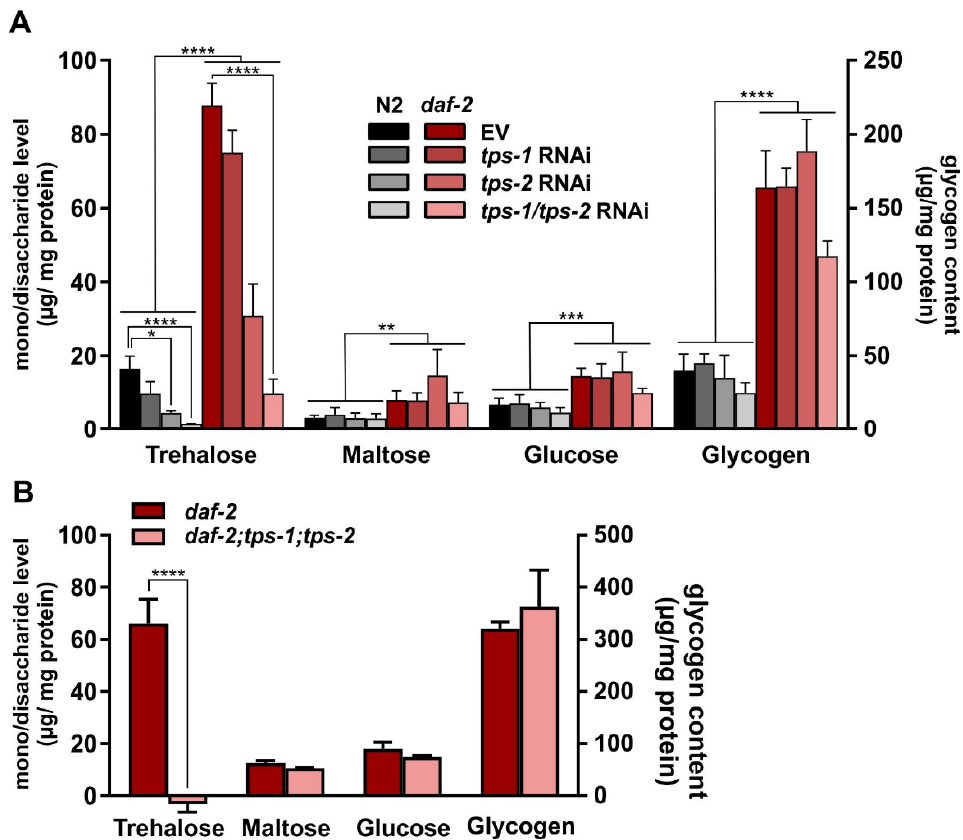
Figure 3. The role of tps-1 and tps-2 in worm carbohydrate levels: ( A ) tps-1 and/or tps-2 RNAi in wild-type N2 and daf-2(e1370) mutants—EV is empty vector control; ( B ) carbohydrates levels in OP50-fed daf-2(e1370) and daf-2(e1370);tps-1(ok373);tps-2(ok526) . All error bars indicate SEM of three independent replicates. * p ≤ 0.05, ** p < 0.01, *** p < 0.001, **** p < 0.0001. Data of all replicates are summarized in Table S3.